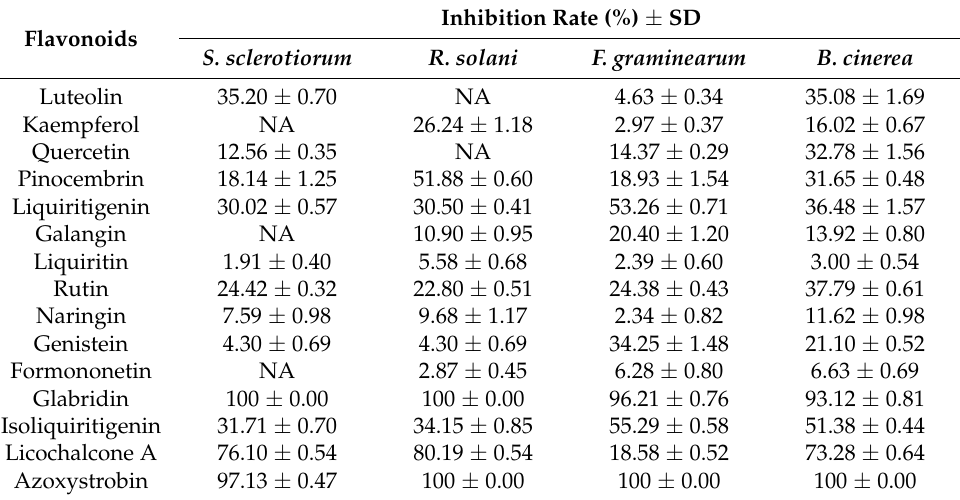
Table 1. In vitro fungicidal activity of compounds from Glycyrrhiza glabra at 500 µ g/mL after three treatments.